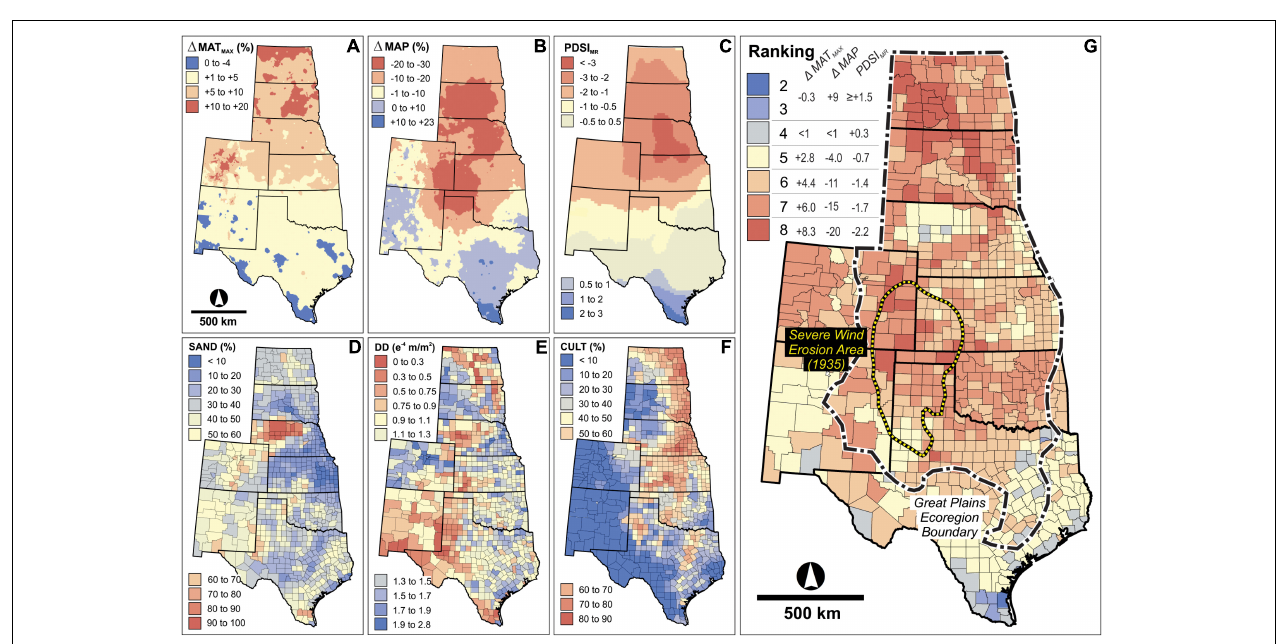
FIGURE 5 | Layers included in the multi-criterion site selection scheme, including climatic factors (A–C) and surficial properties aggregated at the county-level (D–F) : (A) percent change in mean annual maximum temperature (MAT MAX ) during 1931–1940 in comparison to preceding 35-year period (1895–1930), (B) percent change in mean annual precipitation (MAP) during 1931–1940 in comparison to preceding 35-year period, (C) mid-range Palmer Drought Severity Index (PDSI MR ) during 1931–1940, (D) average percent sand, silt, and clay content of soil, (E) average drainage density (DD) expressed as a ratio of total length of linear water features to county area, and (F) the percent of acreage under cultivation at the peak of agricultural expansion in 1935. (G) Criteria were standardized to a scale of 1–9 and given equal influence in a weighted overlay to assign each county a rating based on its respective properties. For data sources, refer to Table 1 .